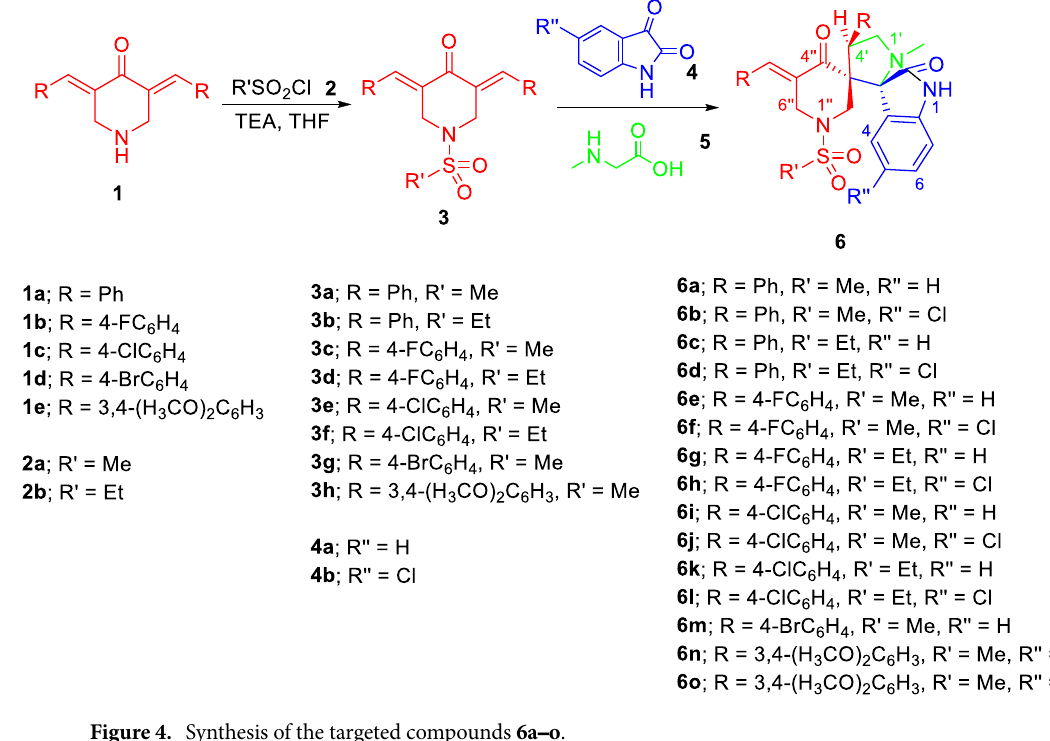
Figure 4. Synthesis of the targeted compounds 6a ‒ o